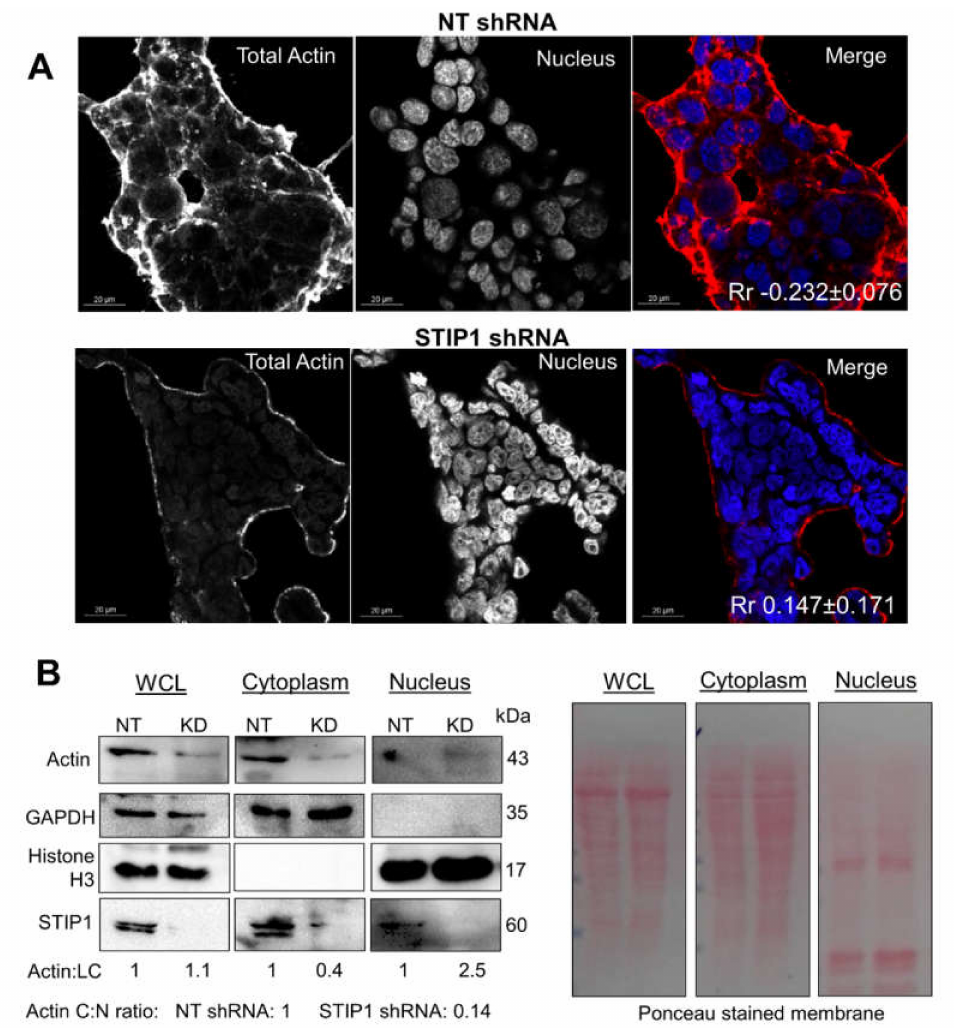
Figure 5. STIP1 regulates actin localization. ( A ) Confocal microscopy in control (NT shRNA) and STIP1-depleted (STIP1 shRNA) HEK293T cells to detect total actin with anti-actin antibody. The text indicates the average Pearson correlation coe ffi cient ( ± SD, n = 3) between the nucleus and actin signals. ( B ) Nuclear-cytoplasmic fractionation and Western blotting of distribution of actin in cells expressing control shRNA or shRNA against STIP1. Actin:LC indicates the densitometry of actin signal to the loading control (GAPDH in WCL and cytoplasm and Histone H3 in nucleus) normalised to the NT shRNA for each fraction. The actin C:N ratio indicates the ratio of the actin:LC signal in the cytoplasm relative to the nucleus normalised to the NT